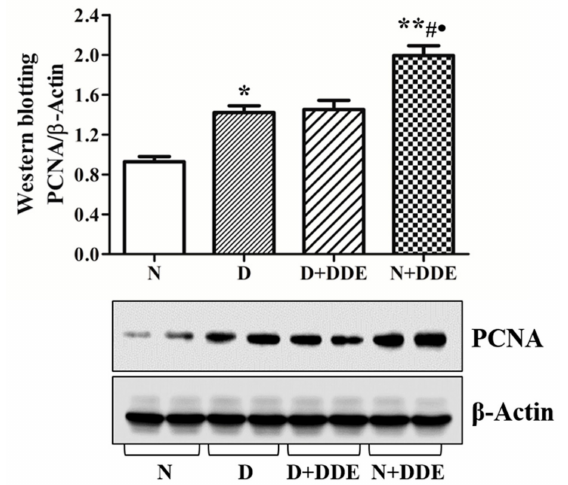
Figure 5. Analysis of proliferating cell nuclear antigen (PCNA) content in testis homogenate. The results obtained as mean ± standard error, were represented as fold of change vs. controls. One-way ANOVA analysis showed significant di ff erences between treated and controls rats:* p < 0.05 vs. N; ** p <